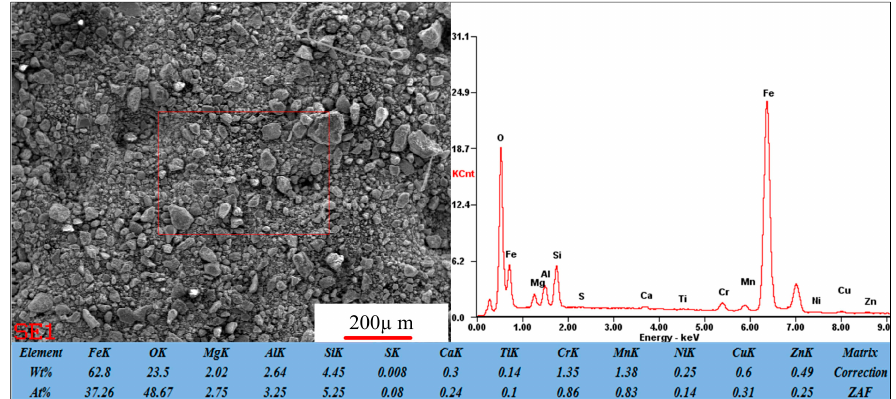
Figure 17. SEM-EDS image of magnetic concentrates obtained from the nickel slag under the optimal conditions.